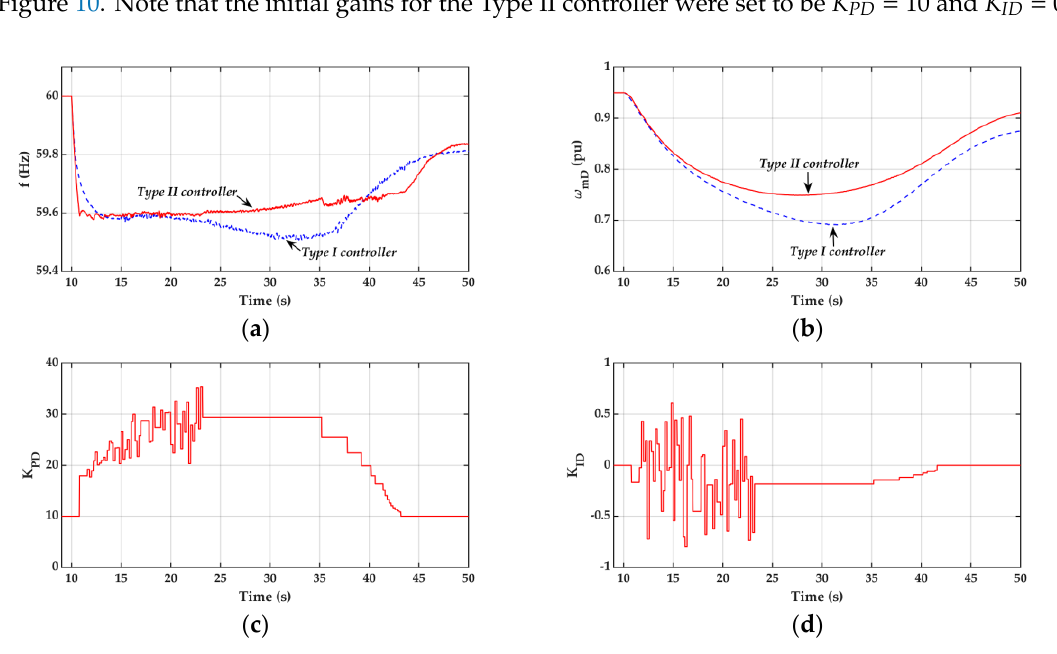
Figure 10. Comparison of dynamic response curves from the Type I and Type II controllers under change of system parameters T sm and T t 4 ( P grid = 45 MW, V w = 11 m / s, T sm = 0.375 s, T t 4 = 6.625 s). ( a ) Frequency, ( b ) DFIG speed, ( c ) PSO proportional gain, ( d ) PSO integral gain.